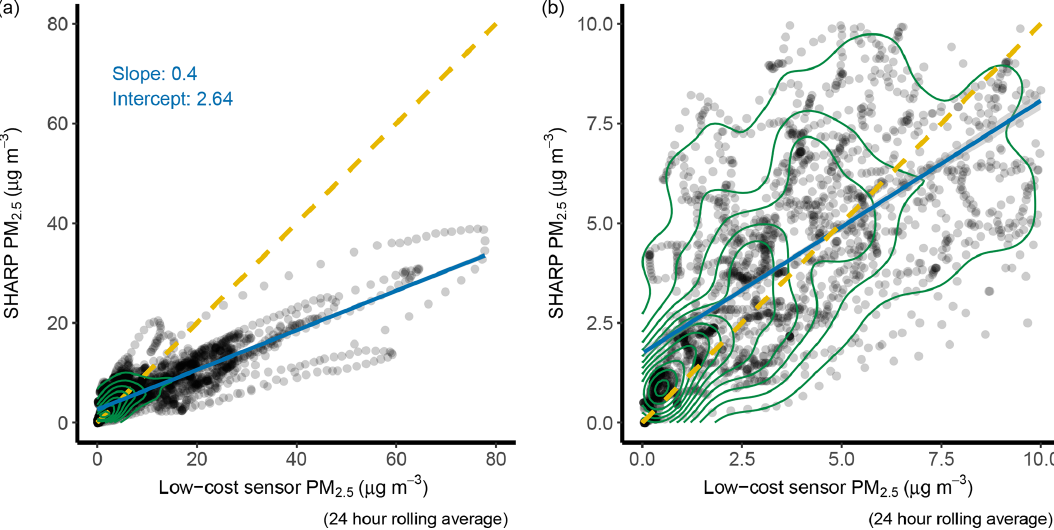
Figure 6. SHARP versus low-cost sensor PM 2 . 5 concentration (µgm − 3 ) . The yellow dashed line is a 1 : 1 line. The solid blue line is a regression line. Panel (a) is in full scale, and panel (b) is a zoom-in plot of panel (a) . The green circle represents data